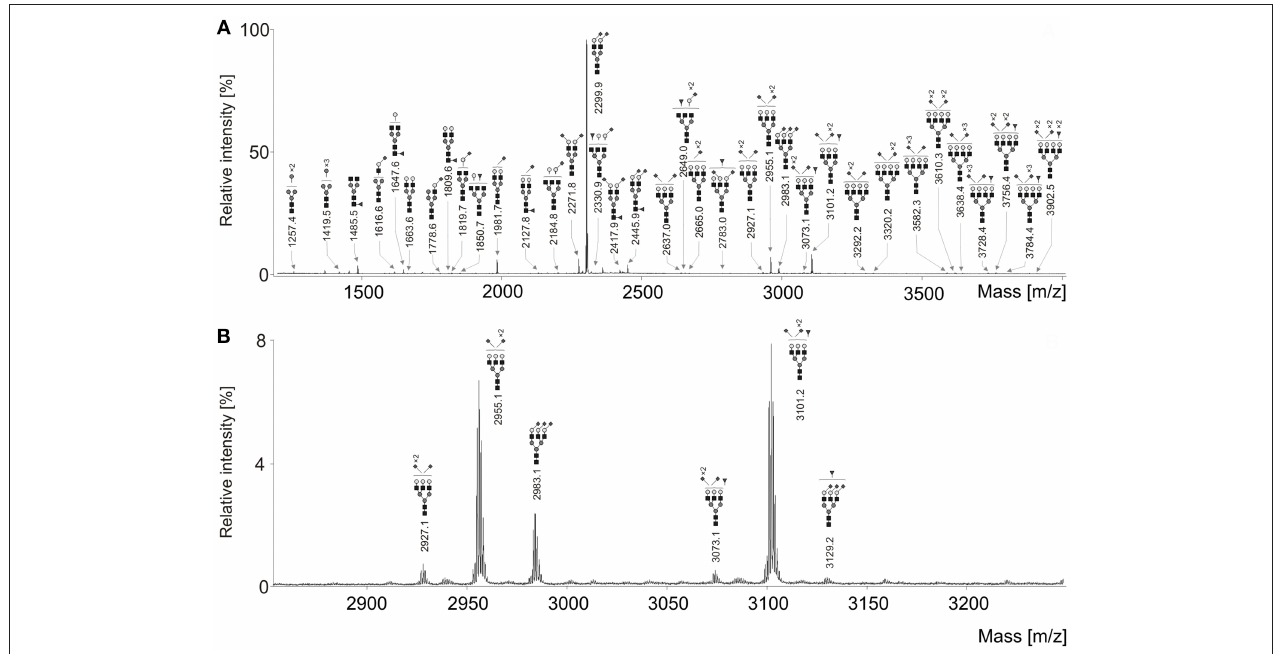
FIGURE 1 | (A) Representative MALDI-TOF mass spectrum of the serum N-glycans of an ovarian cancer patient after linkage-specific sialic acid derivatization. (B) Enlargement of the region 2,850–3,250 Da. Measurements were performed in the positive-ion mode and all molecular ions are present in sodiated form [M + Na] + . Dark gray circle, Man; light gray circle, Gal; black square, GlcNAc; dark gray triangle, Fuc; dark gray diamond, Neu5Ac.